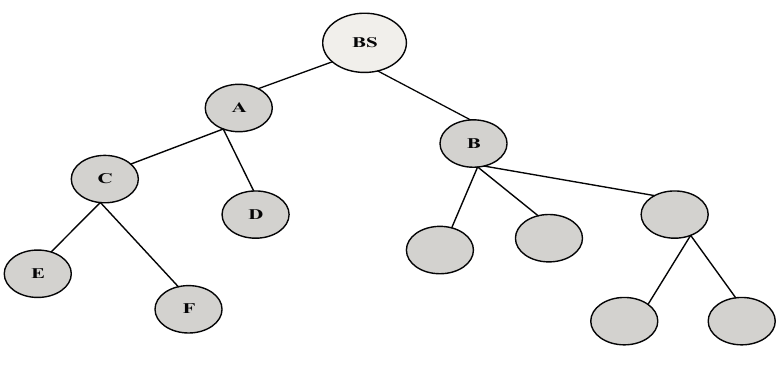
Figure 4. Three level cluster hierarchy